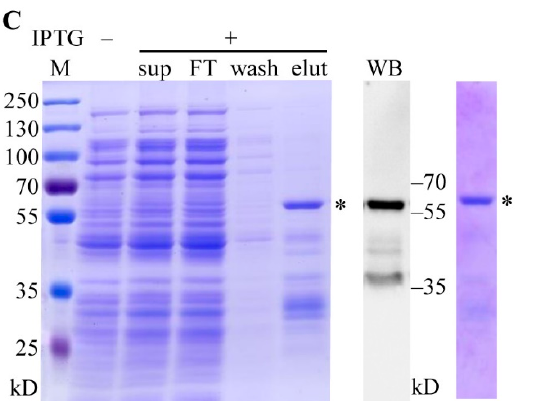
Figure 3. Purifications of His 6 -PACRG and His 6 -GST-PACRG. ( A ) Purification of pCold-PACRG expression product. Left panel: SDS-PAGE analysis and CBB staining of Ni 2+ chelating purification fractions. Sup, supernatant; FT, flow through; w 1–3, fractions washed with sonication buffer, 2 mM and 5 mM imidazole, respectively; elut, fraction eluted with 50 mM imidazole. Right panel: WB analysis of the eluted fraction with PACRG Ab. * denotes His 6 -PACRG. ( B ) Purification of His 6 -PACRG by gel filtration. 4 mL of Ni 2+ -charge purified His 6 -PACRG was loaded on the Sephacryl™ S-200 column, and eluted with the working buffer. The fractions were collected at 1.5 mL/tube manually, and detected with SDS-PAGE and CBB staining. ( C ) Purification of pCold-GST-PACRG expression product. Left panel: CBB staining of GST affinity purification fractions. Sup, supernatant; FT, flow through; wash, fraction washed with sonication buffer; elut, fraction eluted with 20 mM GSH. Middle panel: WB analysis of the eluted fraction with PACRG Ab. Right panel: CBB staining of gel filtration fraction. * denote His 6 -GST-PACRG. M, protein